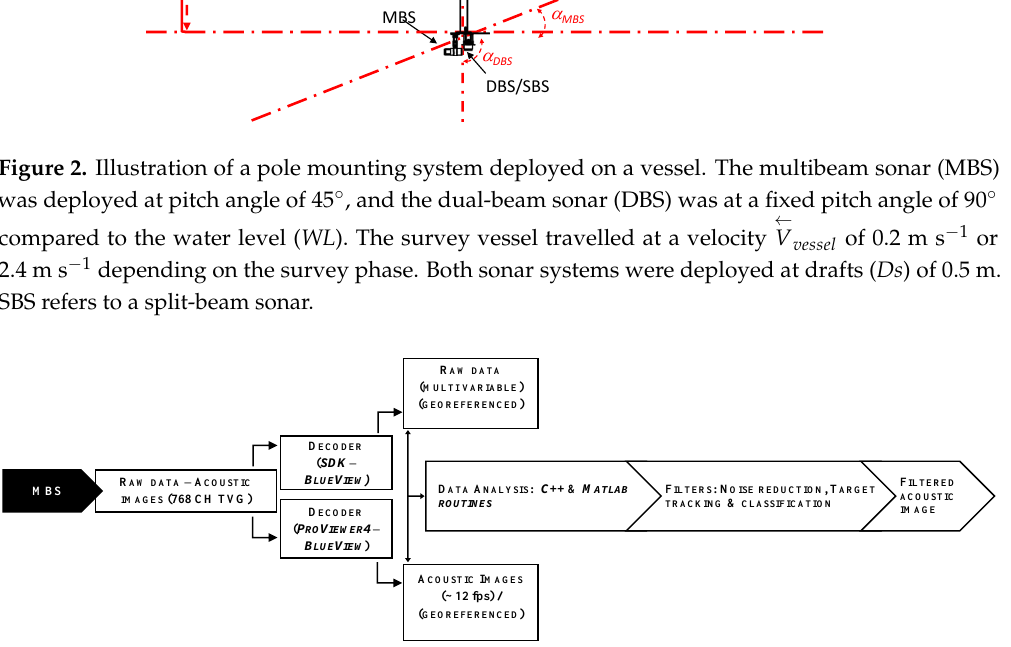
Figure 2. Illustration of a pole mounting system deployed on a vessel. The multibeam sonar (MBS) was deployed at pitch angle of 45°, and the dual-beam sonar (DBS) was at a fixed pitch angle of 90° compared to the water level ( WL ). The survey vessel travelled at a velocity 𝑉← 𝑣𝑒𝑠𝑠𝑒𝑙 of 0.2 m s −1 or 2.4 m s −1 depending on the survey phase. Both sonar systems were deployed at drafts ( Ds ) of 0.5 m. SBS refers to a split-beam sonar.